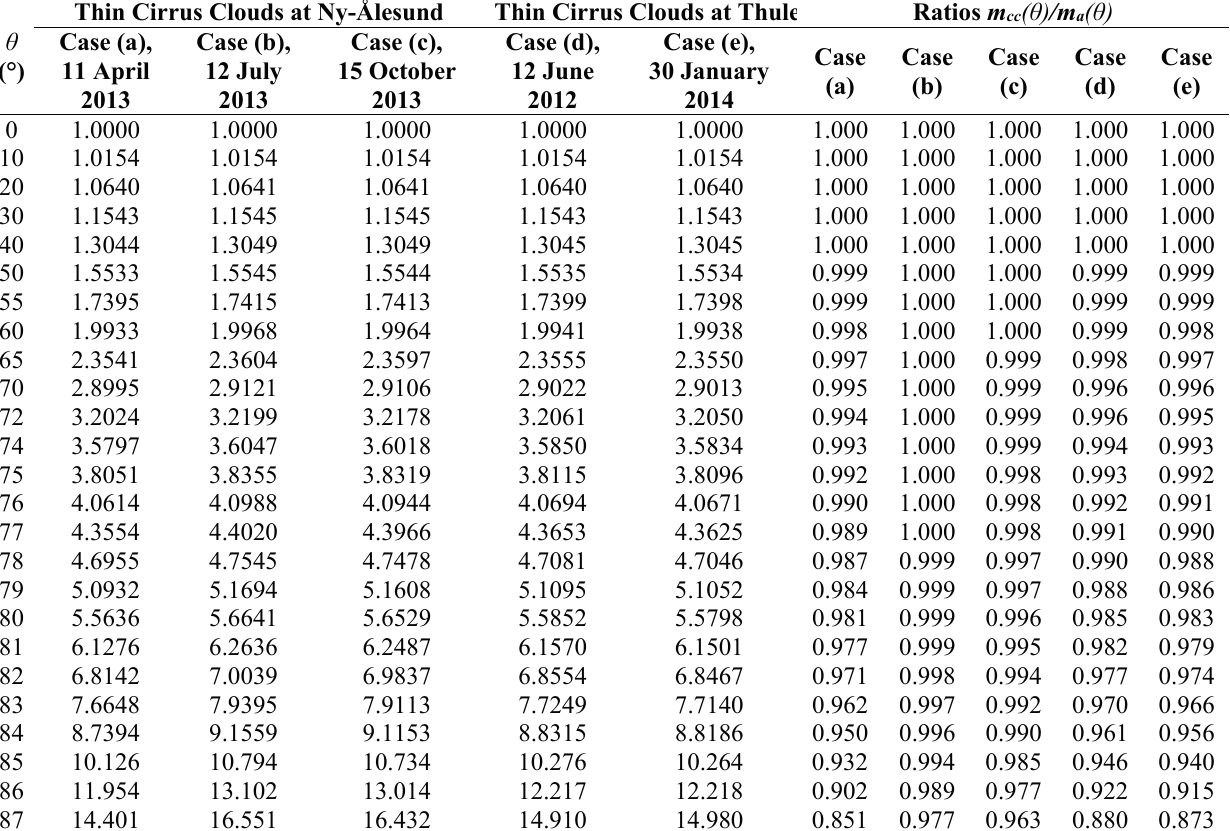
Table 4. Values of the relative optical air mass functions m cc ( θ ) calculated for 25 selected values of apparent solar zenith angle  θ ranging from 0° to 87°, as obtained using as weighting functions in Equation (3) the average vertical profiles of k a ( z ) shown in Figure 5 for three thin cirrus cloud cases observed at Ny-Ålesund on 11 April (15:10 UTC) (case (a)), 12 July (14:49 UTC) (case (b)), and 15 October (12:49 UTC) (case (c)) using the KARL lidar system, and two cirrus cloud cases observed at Thule (76°39'N,